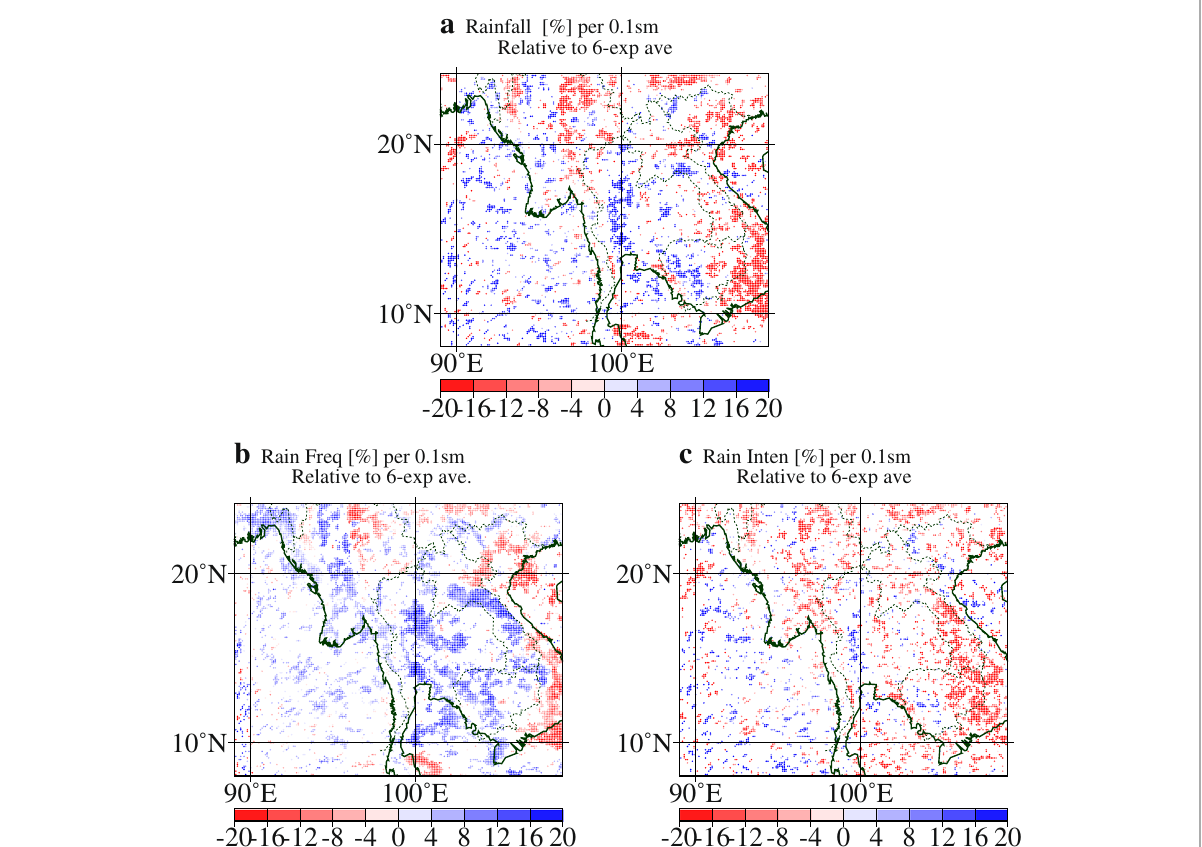
Fig. 6 Same as Fig. 3 but for a rainfall amount, b rainfall frequency, and c rainfall intensity, expressed as a percentage. A detailed explanation is provided in section “The definition of rainfall